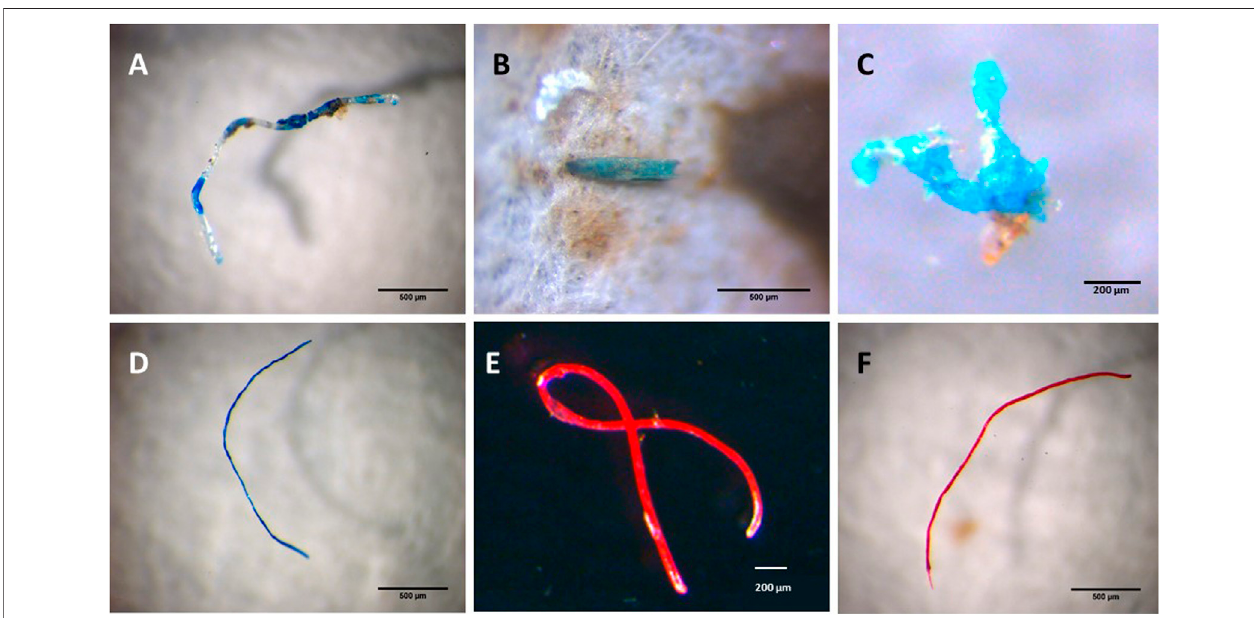
FIGURE2| DifferenttypesofMP. (A) -PET fi berfoundin S.plana ; (B) -PVCfragmentfoundin S.plana ; (C) -PEfragmentfoundin S.colias ; (D) -PET fi berfoundin M. galloprovincialis ; (E) - PP fi ber found in S. colias ; (F) - PET fi ber found in S. plana .